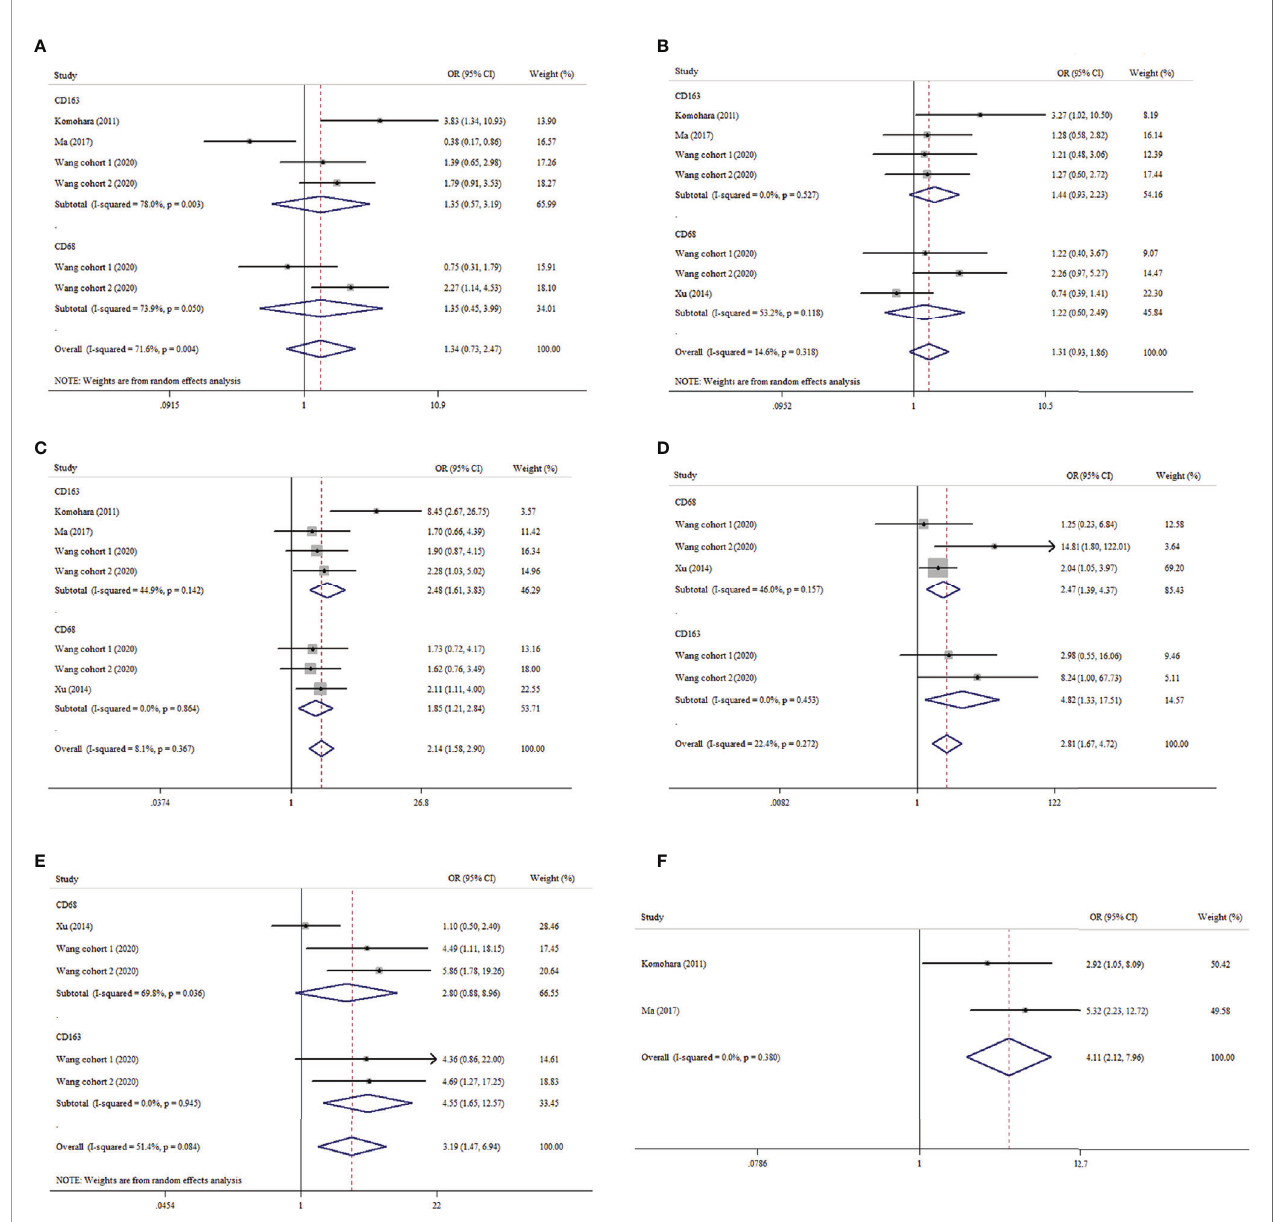
FIGURE 3 | Forest plots of ORs accessing the correlation between CD68+ or CD163+ TAMs density and clinicopathological features. (A) CD68+ or CD163+ TAMs and age; (B) CD68+ or CD163+ TAMs and gender; (C) CD68+ or CD163+ TAMs and nuclear grade; (D) CD68+ or CD163+ TAMs and tumor necrosis; (E) CD68+ or CD163+ TAMs and UICC-stage; (F) CD163+ TAMs and tumor